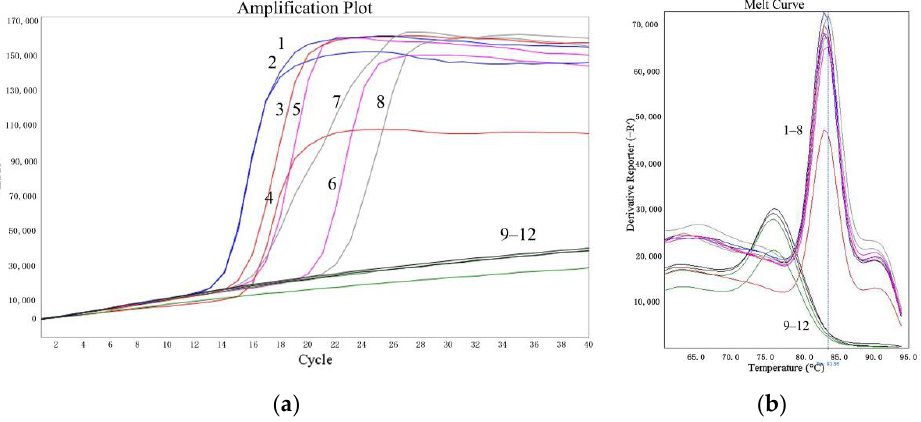
Figure 3. Sensitivity of the LMTIA assay with serial dilution of cassava DNA. ( a ): the amplification plot of the LMTIA assay; ( b ): the melt curve of the LMTIA assay 1, 2: 1 ng; 3, 4: 100 pg; 5, 6: 10 pg; 7, 8: 1 pg; 9, 10: 0.1 pg; 11, 12: ddH 2 O.